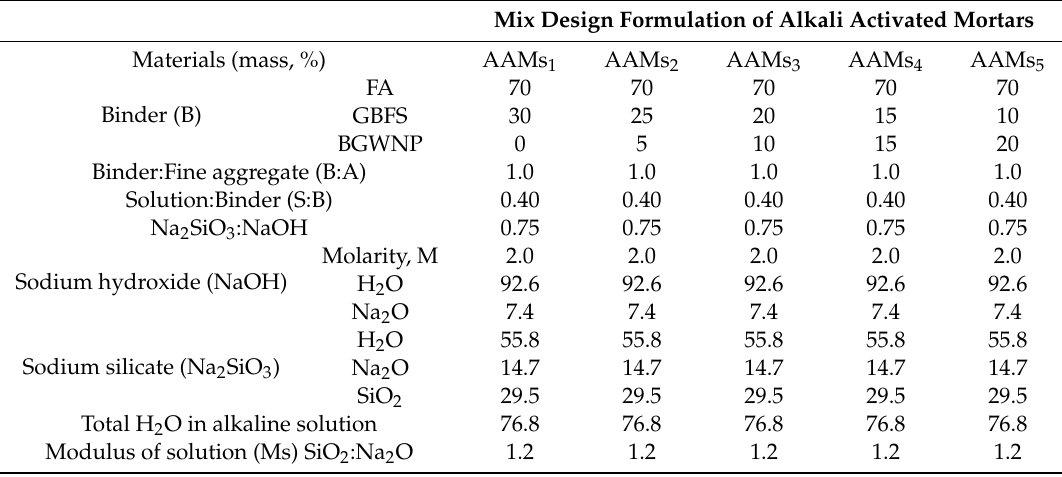
Table 1. Mix design of AAMs prepared with various ratios of BGWNP replacing